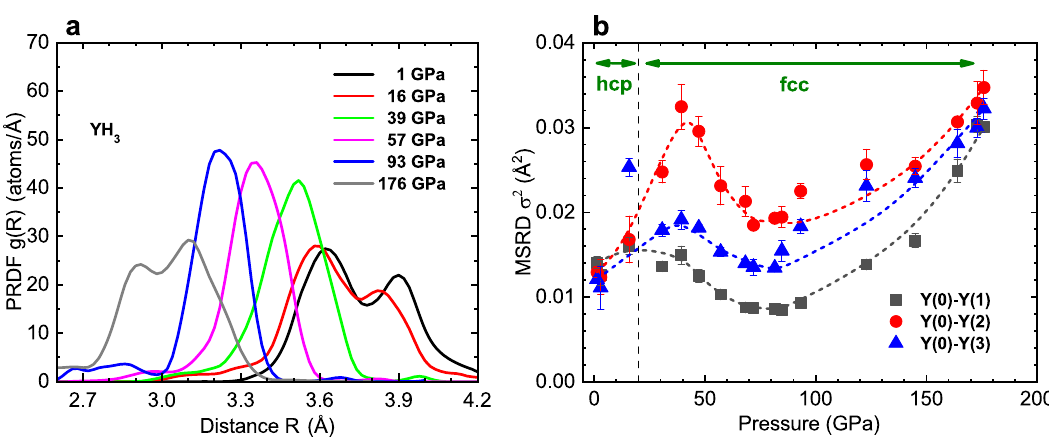
Fig. 8 Pressure dependences of PRDF and MSRD. a The pair radial distribution function (PRDF) of the fi rst Y(0)-Y(1) shell at different pressures up to 176 GPa; b The MSRD pressure dependence for the three nearest Y-Y shells around Y(0) atoms obtained for YH 3 samples S1